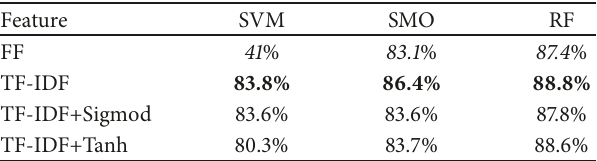
Table 5: Recognition accuracies using three classifiers concerning dataset cairo.